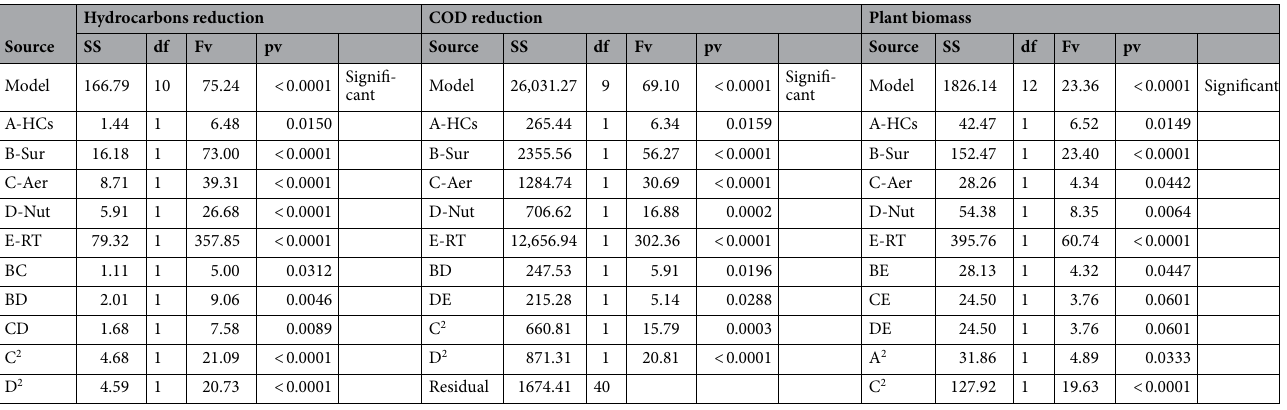
Table 3. ANOVA of the quadratic model for hydrocarbons and COD reduction, and plant biomass production. HCs hydrocarbons, Sur surfactant, Aer aeration, Nut nutrients, RT retention time, SS sum of squares Fv f-value, pv p-value. R -Squared = 0.9505; Adj R -Squared 0.9381; R -Squared = 0.9396; Adj R -Squared 0.9260; R -Squared = 0.8834; Adj R -Squared 0.8456; Pred R -Squared = 0.9169, Pred R -Squared = 0.9045, Pred R -Squared